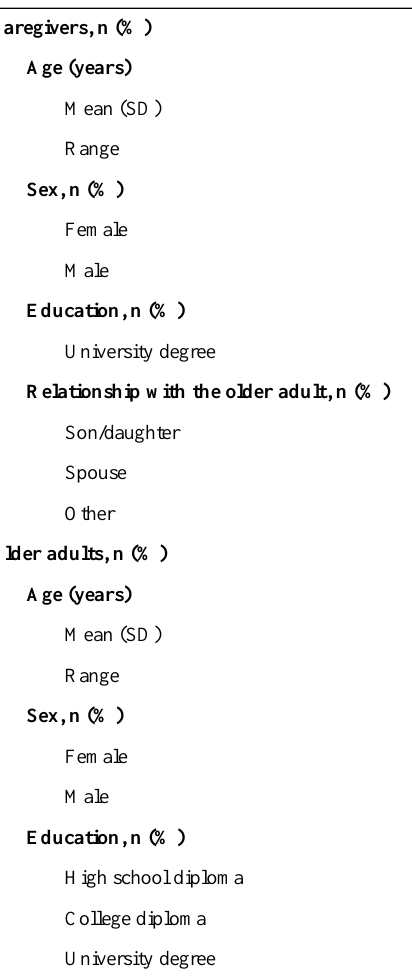
Table 1. Characteristics of end users (N=15).